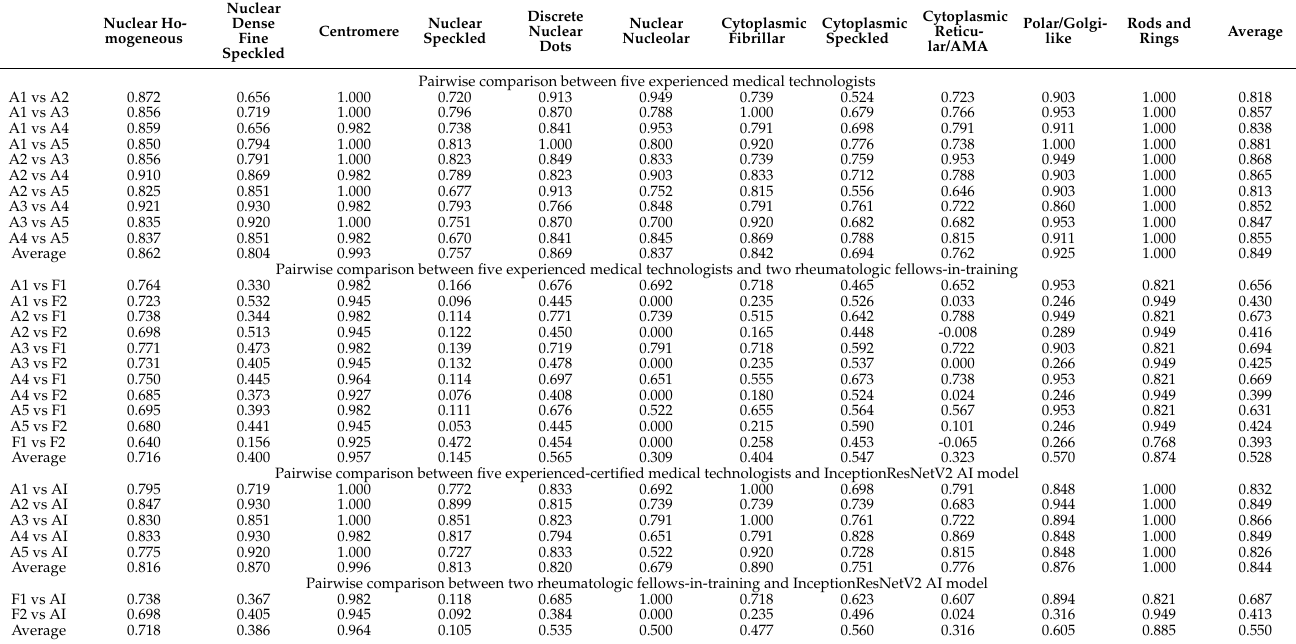
Table 4. Inter-observer agreement (Cohen’s kappa) on Testing Data 2 among five experienced medical technologists (A1–A5), two rheumatologic fellows-in-training (F1–F2), and the InceptionResNetV2 AI model (AI). NuclearHo-